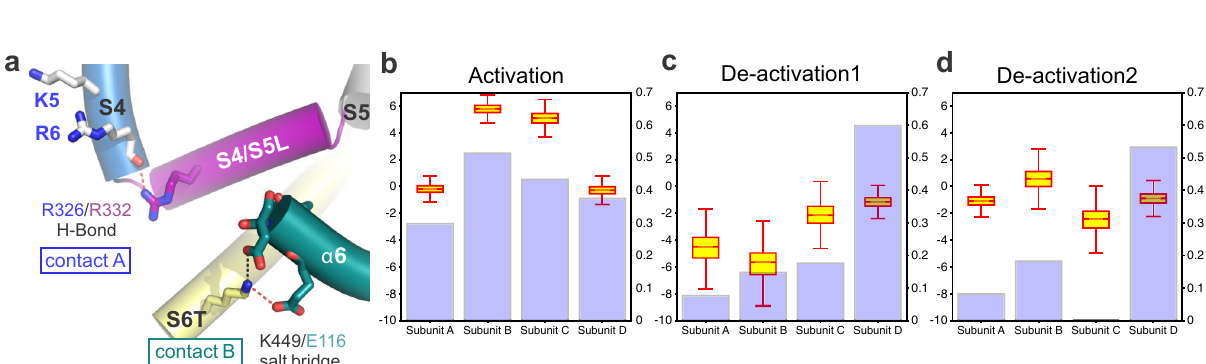
Fig. 6 Mutational and electrophysiological analyses of key residues involved in functional inter-domain interactions between α 6, S4/S5 linker and S6T. a Normalized G – V curves ( G / G max ) of Kv3.1a WT and the indicated mutants. The symbols and error bars represent mean ± SEM ( n = 9 – 19 oocytes), and the solid lines are the best fi ts assuming a fi rst-order Boltzmann equation (see the “ Methods ” section). b Scatter graphs comparing of V 0.5 values from WT and several Ala mutants. Each symbol represents a measurement from an individual oocyte, and the overlaid horizontal line represents the mean value. In each group, n = 9-19 oocytes. P values are indicated on the graph. c Normalized G – V curves for the indicated α 6 mutations as described for panel ( a ). In each group, n = 10-11 oocytes. d Scatter graph for the indicated α 6 mutations as described for panel ( b ). In each group, n = 10 – 11 oocytes. e Left: Overlay of representative whole-oocyte currents from Kv3.1a WT and the mutant H336A at 50 mV. These currents were evoked by the voltage protocol shown in the inset. Centre: Overlay of representative whole-oocyte currents from Kv3.1a WT and the mutant H336A while the repolarizing voltage is 0 mV. From a holding voltage of − 100 mV, these currents were evoked by a 30-ms step depolarization to + 50 mV, which was immediately followed by a 100-ms repolarizing step. To determine the voltage dependence of deactivation, the repolarizing step was changed in 10-mV increments from − 140 to + 30 mV (inset). The horizontal and vertical scale bars indicate 100 ms and 1 μ A, respectively. Right: The voltage dependence of the time constants of activation (hollow symbols) and deactivation ( fi lled symbols) from Kv3.1a WT and H336A. f Left and centre: overlay of representative whole-oocyte currents from Kv3.1a WT and the double mutant E116A/D120A. Protocol details as described for panel ( e ). The horizontal and vertical scale bars indicate 100 ms and 1 μ A, respectively. Right: The voltage dependence of the time constants of activation (hollow symbols) and deactivation ( fi lled symbols) from Kv3.1a WT and E116A/D120A. Symbols and error bars in panels e and f represent the mean ± SEM and * indicates p < 0.001. Source data are provided as a Source Data fi le. Exact n and p values for panels a – d are listed in Supplemental Table 2.